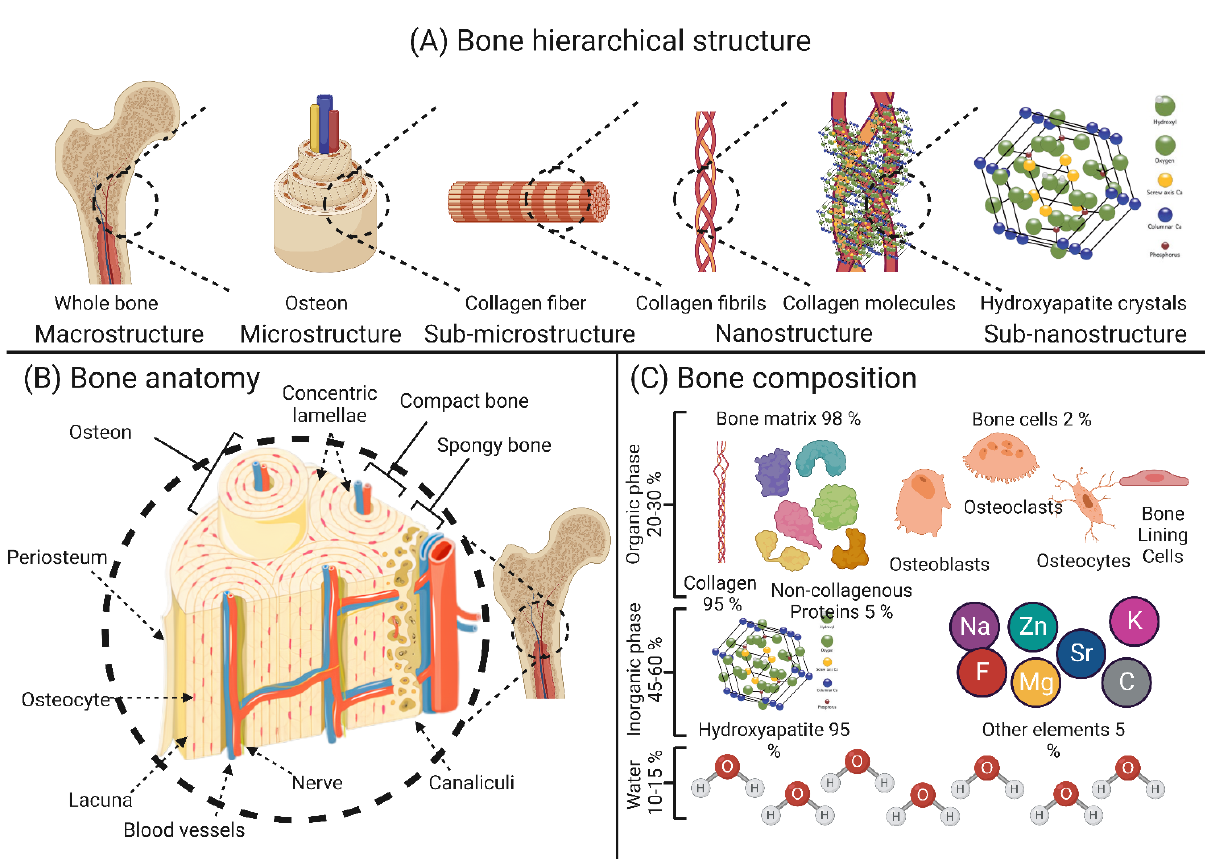
Figure 1. Schematic representation of the basic structure of bone tissue: ( A ) hierarchical structure of the bone; ( B ) anatomical features of the bone; ( C ) elemental composition of the bone. The image was created using Biorender.